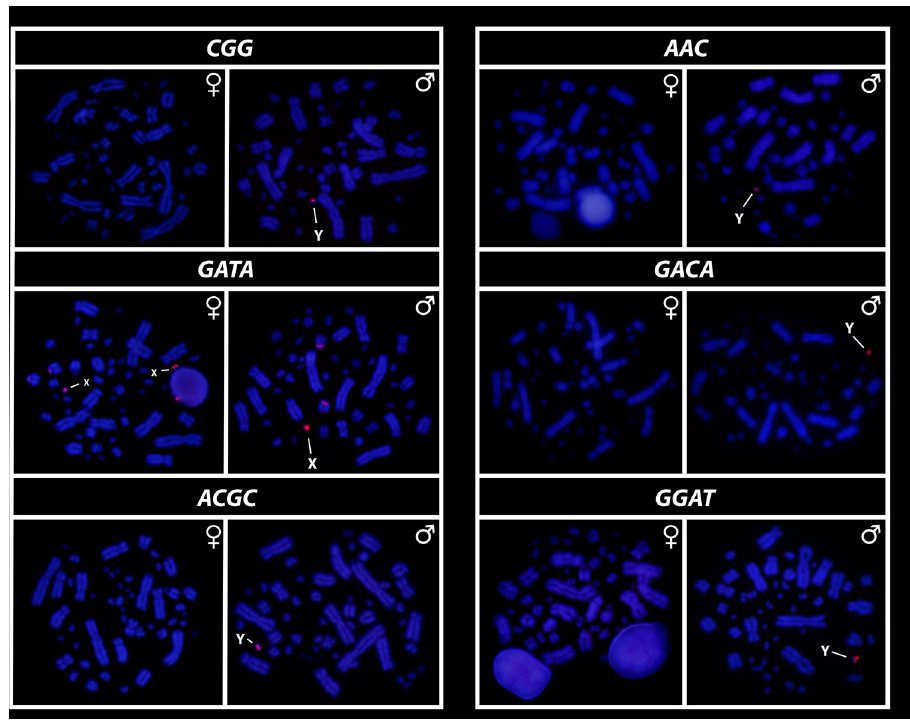
Figure 3. Mapping of tri and tetra-nucleotids on the chromosomes of male and female of Chelus fimbriata . Note the unique pattern of GATA motifs on X chromosomes (lines). The other SSRs showed only Y-specific accumulation (lines).